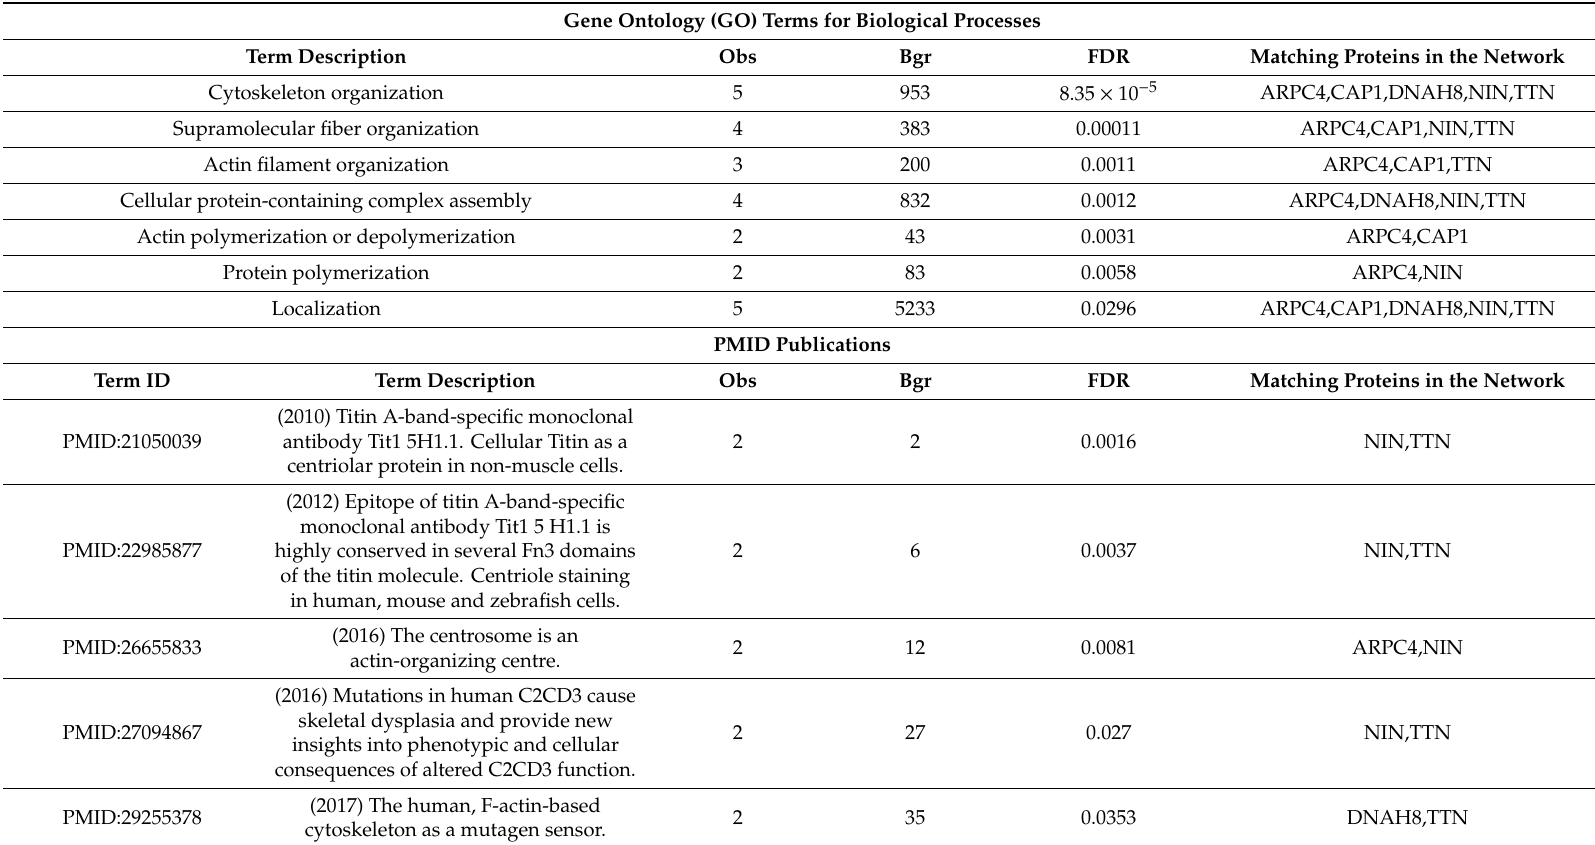
Table 5. Biological processes and PMIDs for the EV surface unique proteins in the HIV group for the HIV vs. HIV + A β comparison. Gene Ontology (GO) Terms for Biological Processes Term Description Obs Bgr FDR Matching Proteins in the